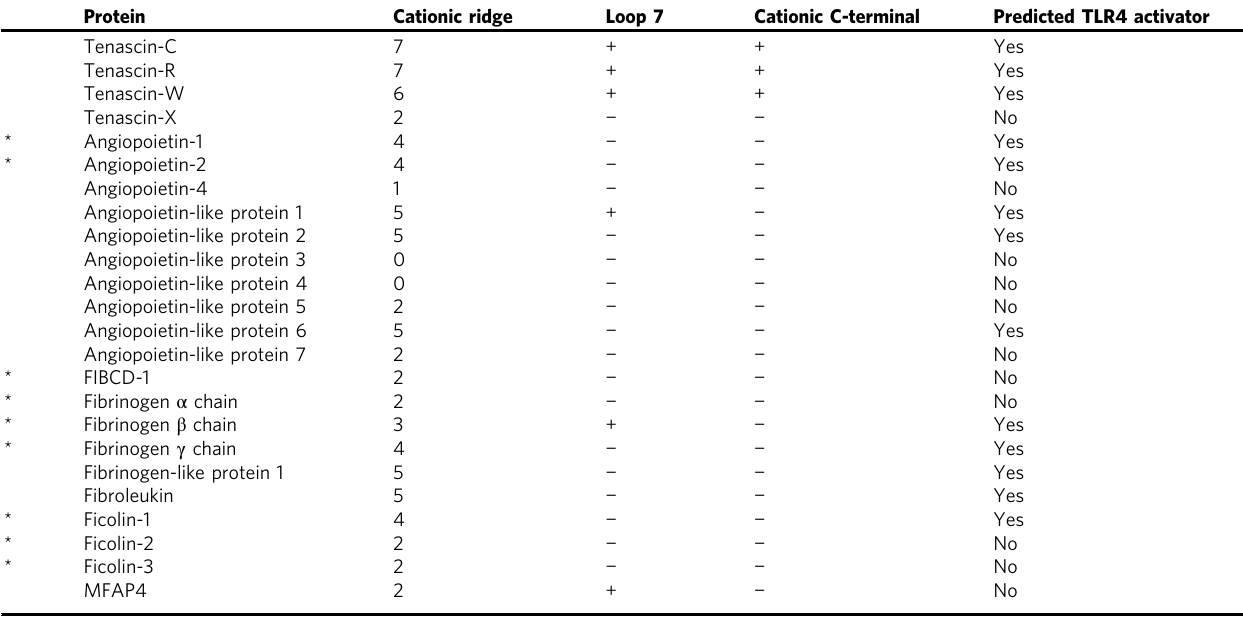
Table 1 Conservation of epitopes involved in TLR4 activation in human FRePs Protein Cationic